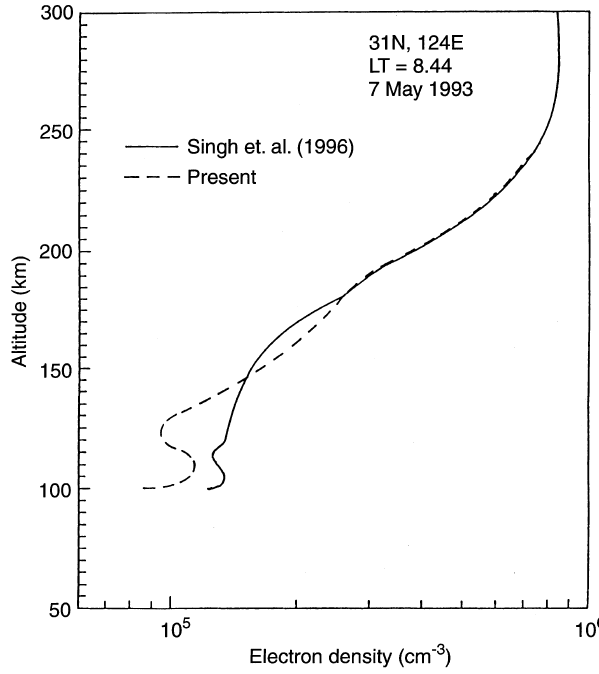
Fig. 3. Relative variation of electron densities obtained from the present model and IRI-86 model